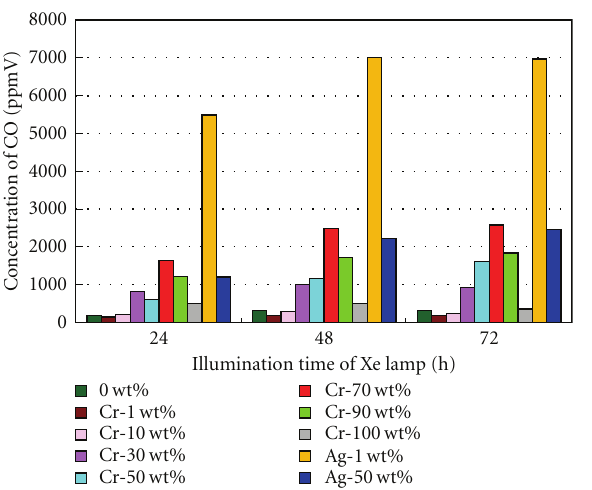
Figure 12: Comparison of product by CO 2 reforming after illumination of Xe lamp with UV light of 72h for several Cr-doped TiO 2 film prepared under conditions of di ff erent N .